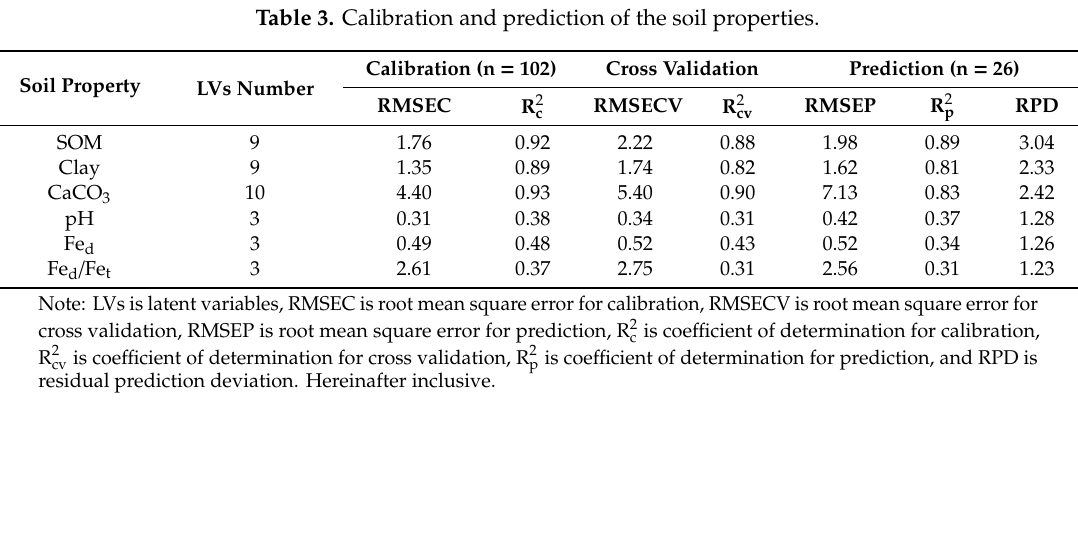
Table 3. Calibration and prediction of the soil properties.